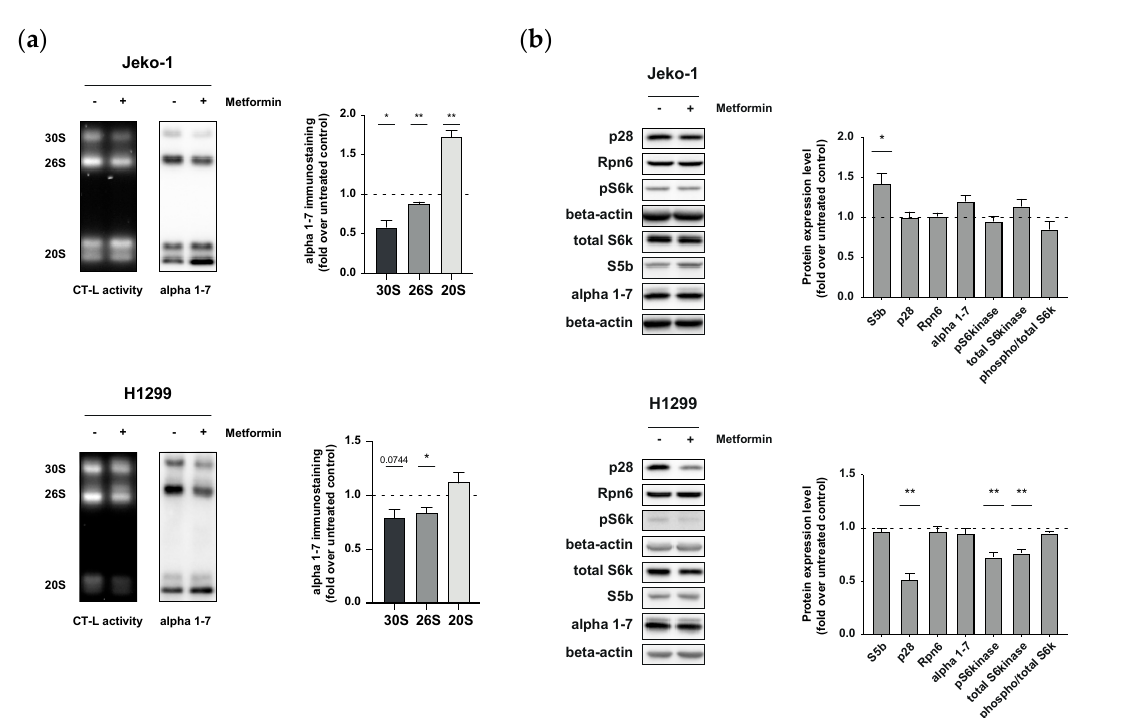
Figure 2. Metformin treatment leads to downregulation of 30S and 26S proteasome assembly. ( a ) Representative in-gel chymotrypsin-like substrate activity assay of native cell lysates from Jeko-1 and H1299 cells treated with 10 mM metformin for 72 h (left panels) followed by immunostaining of 20S alpha 1-7 subunits of blotted native gels (right panel). Quantification of 30S, 26S, and 20S is presented as mean + SEM relative to the untreated control. Significance was determined using Student’s one-sample t-test. ( b ) Representative Western blot analysis of 26S assembly factors (S5b, p28, and Rpn6) and 20S (alpha 1-7 subunit) as well as of phosphorylated and total p70 S6 kinase (S6k) expression in Jeko-1 and H1299 cells treated with 10 mM metformin for 72 h. Beta-actin was used as loading control. Bar graphs of densitometric analysis show mean + SEM relative to the untreated control. Significance was determined using Student’s one-sample t-test. * p < 0.05; ** p < 0.01.